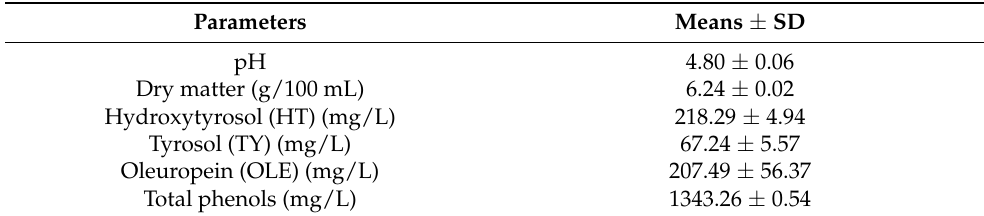
Table 1. Chemical parameters of olive mill wastewater (OMW) after pretreatment (centrifugation and filtration).